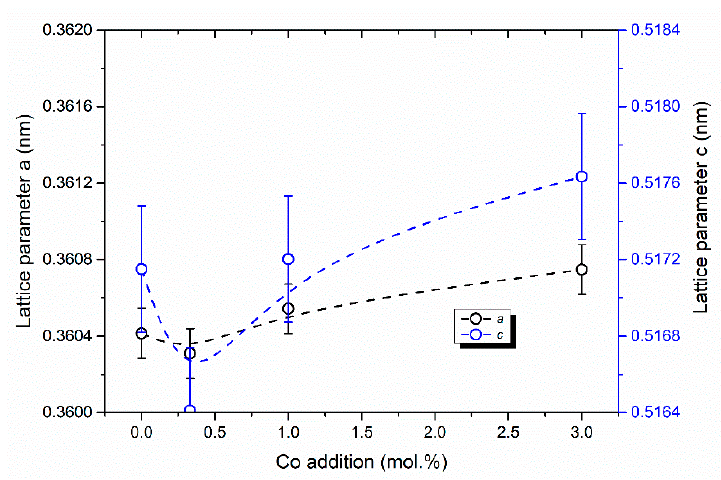
ff ect of the Co amount on the cell parameters on the samples sintered at 1350 ◦ Figure 5. The effect of the Co amount on the cell parameters on the samples sintered at 1350 °C. Figure 5. The e